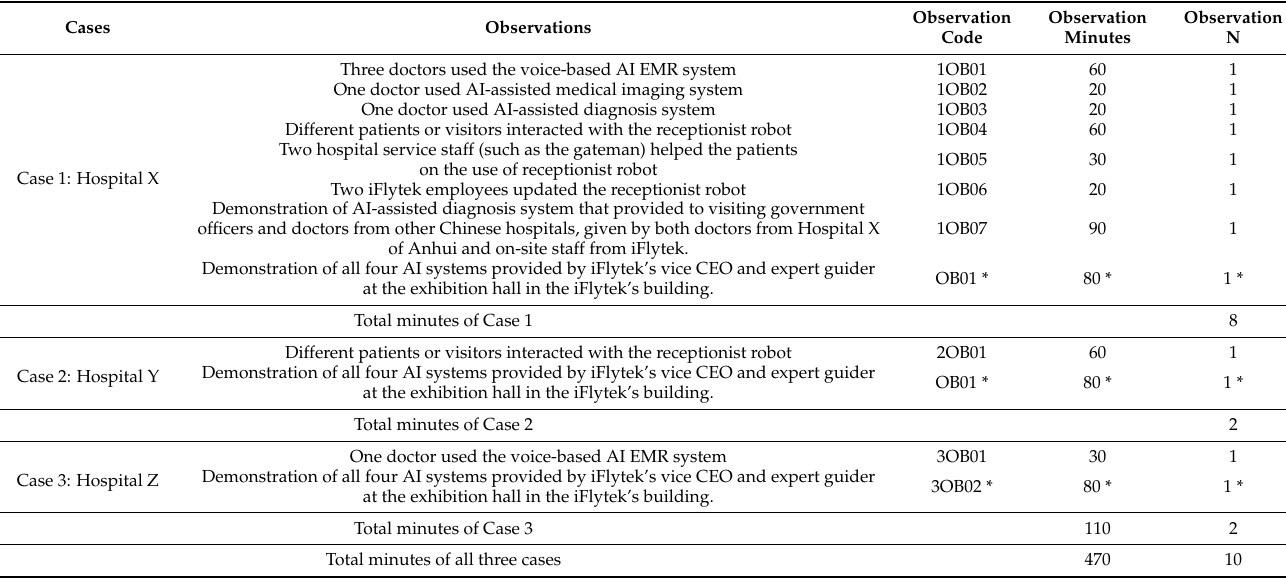
Table 4. Participant observation data